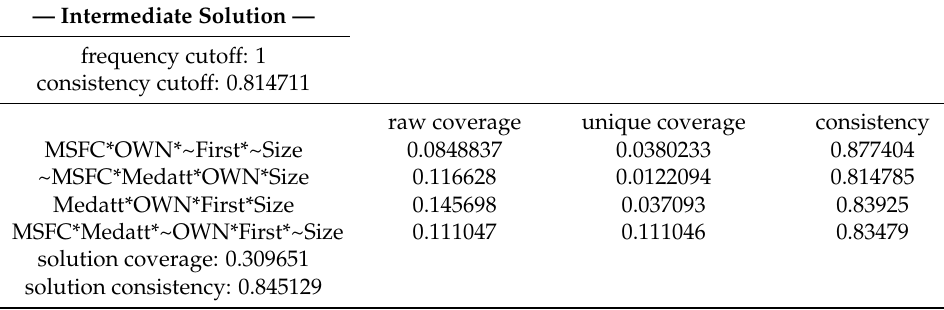
Table 6. Intermediate solution of fsQCA output (consistency: 0.8).